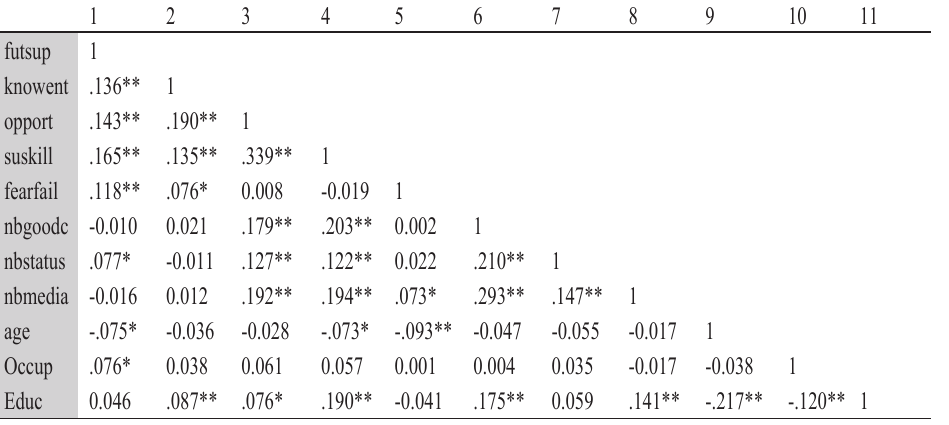
Table 04: Correlations among variables of